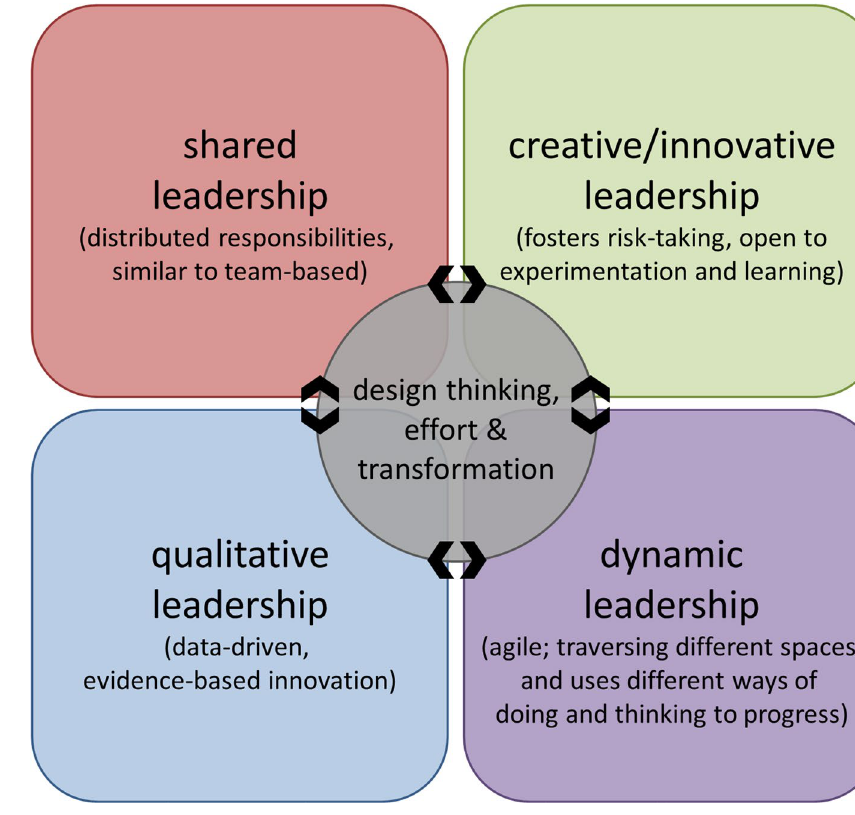
Fig. 2 Innovative model for academic leadership. New modes for academic leader- ship that transcend tradi- tional gatekeeping modes of leading that maintain status quo are needed and four are proposed here, including shared leadership, creative or innovative leadership, qualita- tive leadership, and dynamic leadership. Progressive lead- ers (represented by the center gray circle with bidirectional arrowheads) are able to move in and out of these four modes in response to eco- system needs, demands, and changes through using design thinking and initiating effort towards ecosystem trans- formation. Decision-making and analytics informed by real-time data acquisition and environmental dynamics can dictate the rate and timing of pivotal shifts through the respective leadership